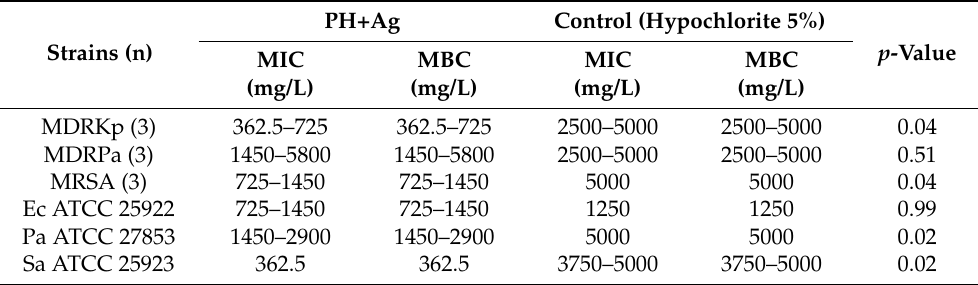
Table 3. In vitro antibacterial activity of HP + Ag against resistant clinical isolates of K. pneumoniae , P. aeruginosa , and S. aureus , and ATCC